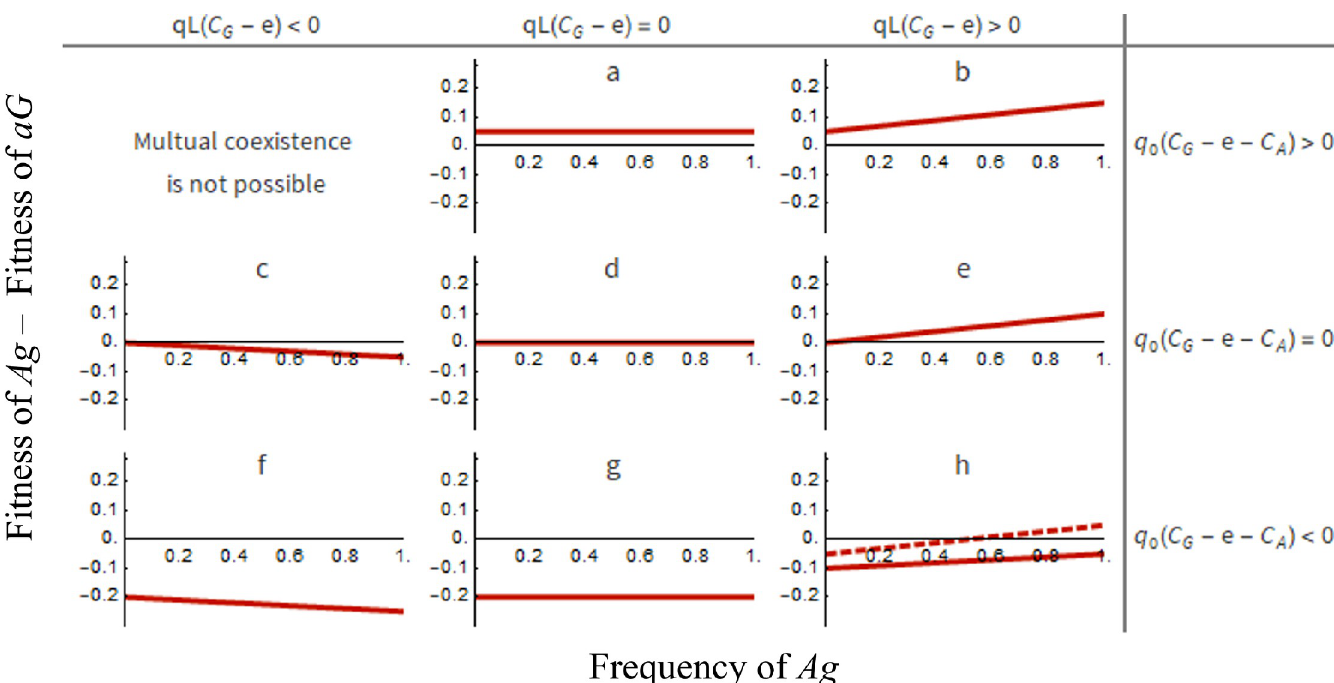
Fig 5. Partial privatization cannot favor coexistence of functionally complementary strains. The interaction between Ag and aG will always lead to pure populations of one of them. If the line is entirely below the x-axis, then aG always outcompetes Ag . If the line is entirely above the x-axis, then Ag always outcompetes aG . The point of intersection between the line and the x-axis indicates that both strains are equally fit. Selection cannot favor coexistence because the point of intersection, dotted line, only exists when the most common strain has the advantage over the rare strain (hence we have positive frequency-dependent selection, not negative frequency- dependent selection). qL ( C ) is the inclination of the line and represents the metabolic balance from QS regulation. q 0 ( C ) is the point of intersection with the G − e G − e − C A y-axis and represents the metabolic balance from QS-independent regulation. Regarding the effect of QS regulation ( q ): qL ( C G − e ) < 0 indicates that the per capita partially privatized benefit offsets the per capita good’s cost; qL ( C ) = 0 indicates a lack of QS regulation or a lack of QS-independent autoinducer secretion; qL ( C ) G − e G − e > 0 indicates that the per capita partially privatized benefit cannot offset the per capita good’s cost. Regarding the effect of QS-independent regulation ( q 0 ): q 0 ( C G − e − C A ) > 0 indicates that the per capita good’s cost is higher than the sum of the per capita partially privatized benefit and the per capita autoinducer’s cost; q 0 ( C G − e − CA ) = 0 indicates a lack of QS-independent regulation; q 0 ( C G − e − C A ) < 0 indicates that the per capita good’s cost is lower than the sum of the per capita partially privatized benefit and the per capita autoinducer’s cost. All mathematical analyses assumed an unstructured